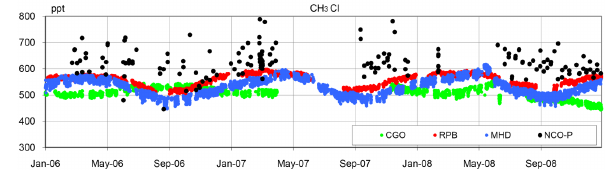
Fig. 8. CH 3 Cl measured at NCO-P (all data) compared with base- line data at at MHD (blue), RPB (red) and CGO (green).